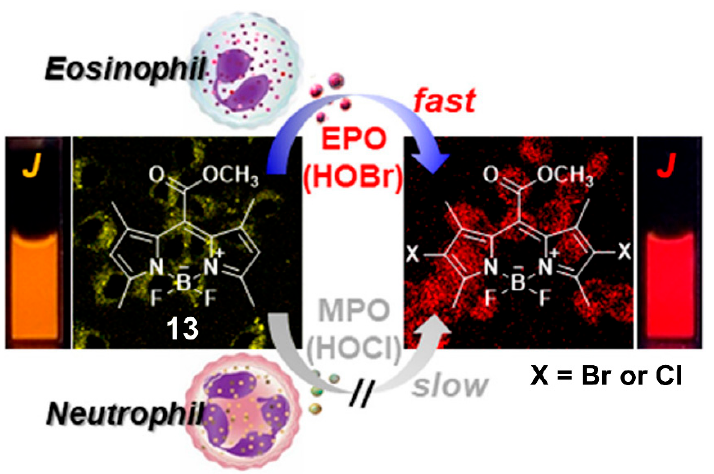
Figure 13. BODIPY-based fluorescent probe 13 for selective recognition of HOBr through dibromi- nated substitution. Reproduced with permission from Reference [103]. Copyright 2018 American Chemical